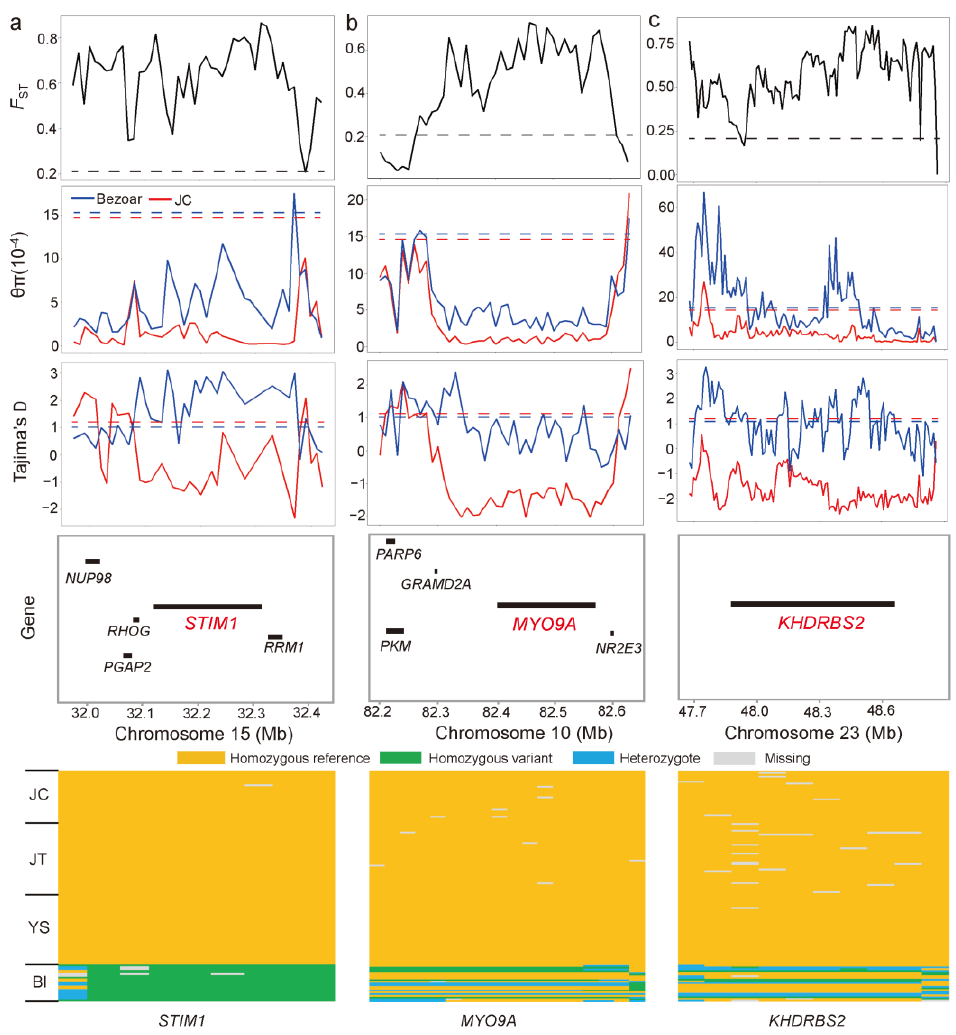
Figure 5. Summary of three examples of selective sweep regions. Three selection signals encompass STIM1 on Chromosome 15 ( a ), MYO9A on Chromosome 10 ( b ), and KHDRBS2 on Chromosome 23 ( c ), respectively. The putative sweep regions were additionally validated by π and Tajima’s D values. Horizontal dashed lines represent the whole-genome mean for the corresponding parameters. Gene annotations in the sweep region and SNPs fixed for reference alleles in three black goat breeds are indicated at the bottom.